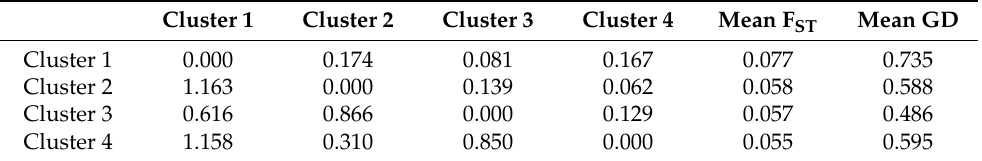
Table 6. Pairwise differentiation of clusters (F ST ) (above diagonal) and Nei’s genetic distance between clusters (below diagonal) and mean F ST and genetic distance of each cluster from the other three clusters. All pairwise F ST values were significant at p <